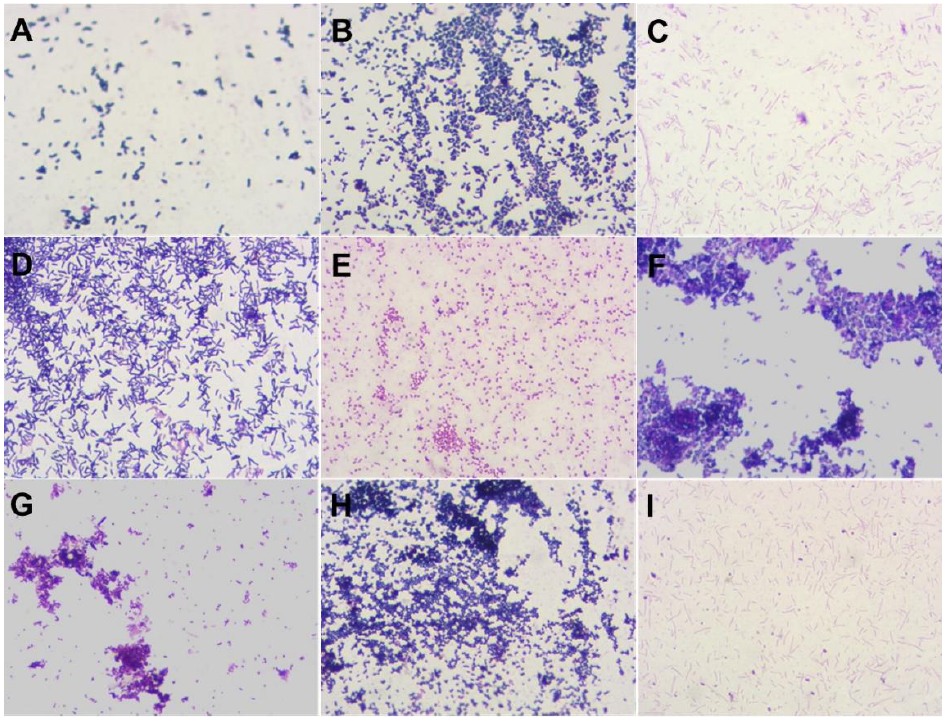
Figure 1. Microorganisms observed in the GCF: Lactobacillus spp. (light microscopy, magnification